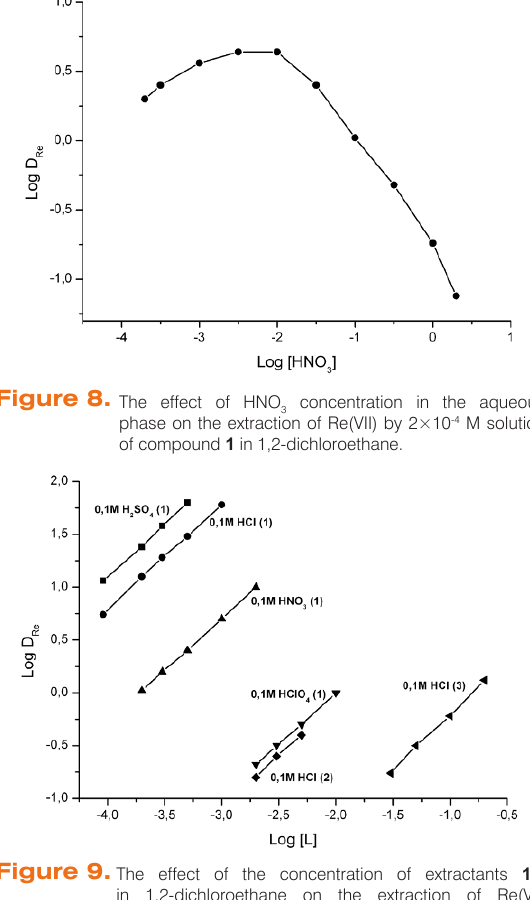
, 0.1 M HClO , and 0.1 M H SO 3 4 2 4